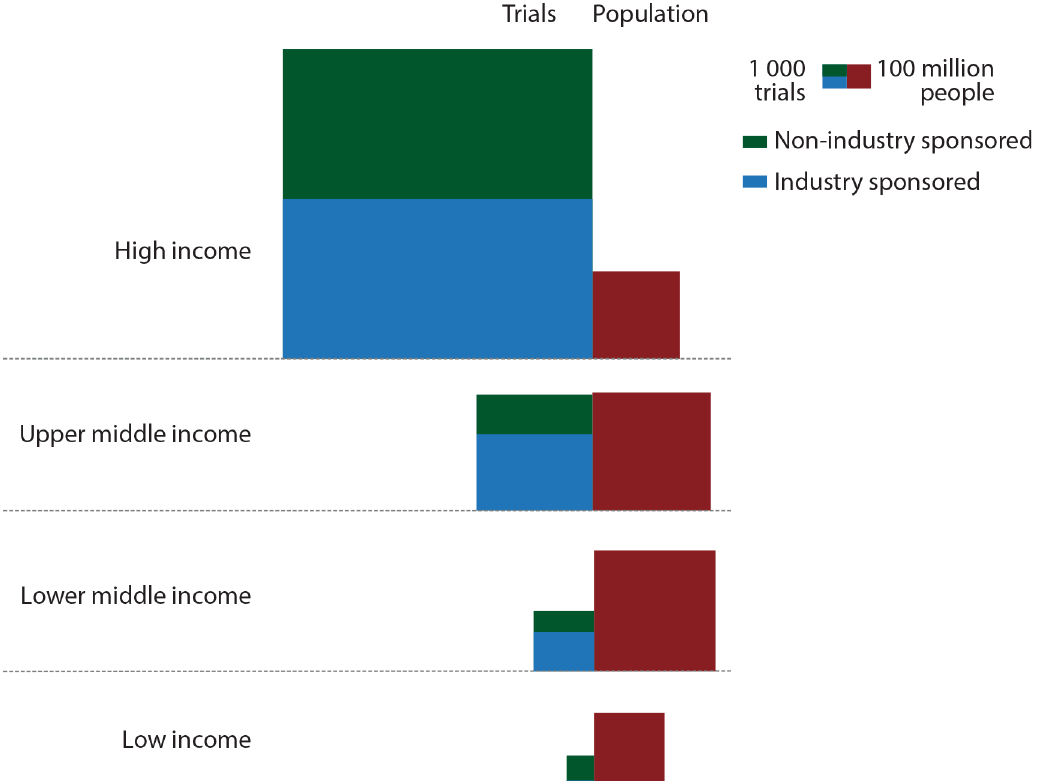
Fig 1. Distribution of clinical trials and population per income groups. For each income group, the size of the green (blue, respectively) area is proportional to the number of industry-sponsored (non-industry – sponsored) trials initiated during the 2006 – 2013 period, and the size of the red area is proportional to the population as of 2012. Equal-sized trial and population squares correspond to an overall density of 10 trials per million inhabitants. The proportion of industry-sponsored clinical trials was 51.6%, 66.0%, 65.4% and 9.3% in high-, upper-middle-, lower-middle- and low-income countries, respectively. In high-income countries, the density of trials ranged from 2.2 trials per million inhabitants in Trinidad and Tobago to 645.7 for Denmark. In upper-middle-income countries, it ranged from 0.05 to 225.9, with more than 50 trials per million inhabitants in four countries, all in Eastern Europe (Hungary, Bulgaria, Romania and Serbia). The variation was less pronounced in lower-middle-income countries (between 0.04 and 22.6) and low- income countries (between 0.13 and 14.0).